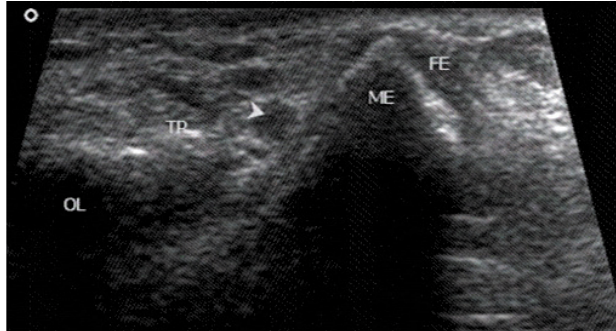
Fig. 5. The asymptomatic right elbow at the level of the cubital tunnel is depicted at full flexion following continuous dynamic monitoring by keeping the transducer fixed over the medial epicondyle (ME) during flexion. The ulnar nerve (arrowhead) and medial head of triceps (TR) remain in the cubital tunnel posterior to the medial epicondyle with no evidence of